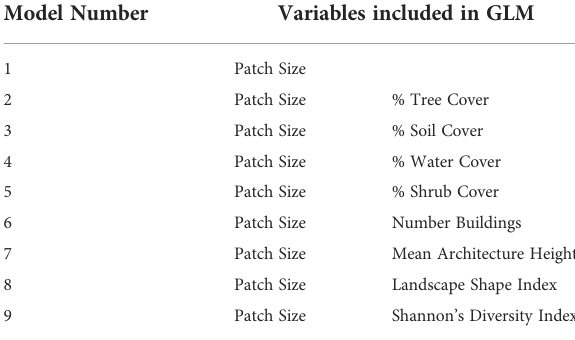
TABLE 6 List of best performing models ( D AICc <